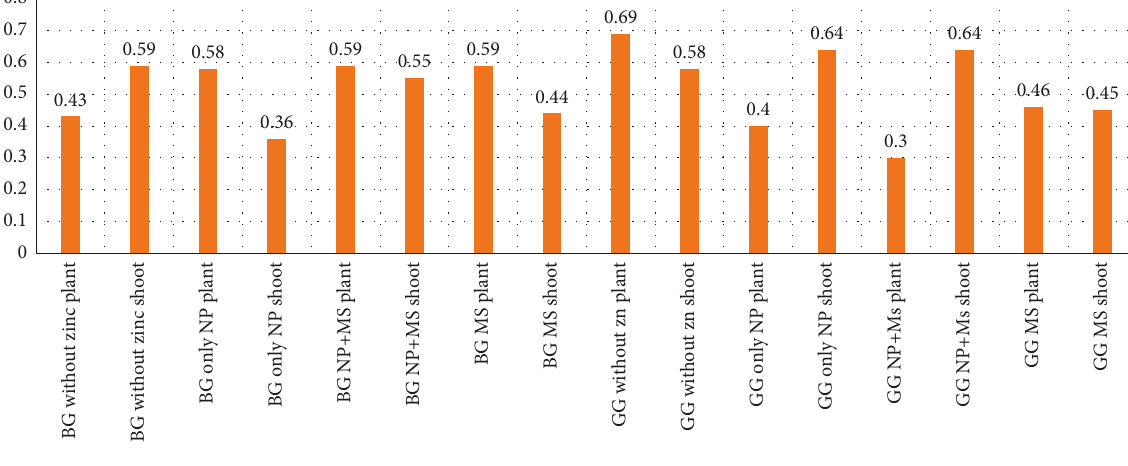
Figure 9: Protein estimation after 14 days, the 2nd set. BG: Bengal gram and GG: green